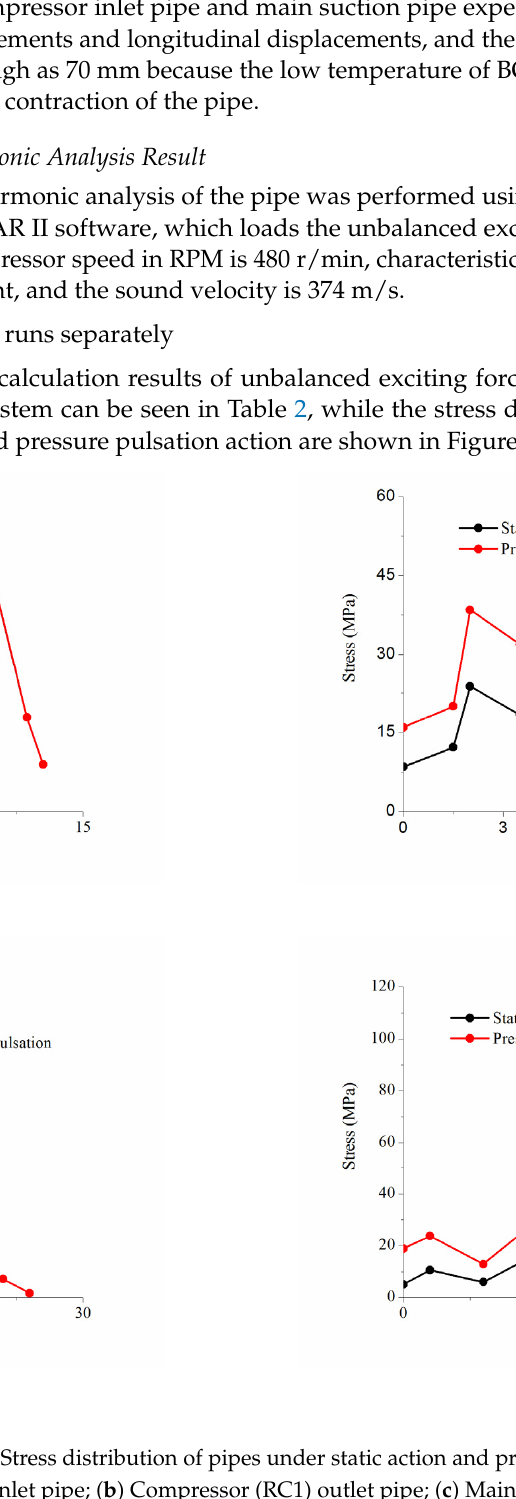
13 of 22 Figure 11. Displacement distribution: ( a ) Compressor (RC1) inlet pipe; ( b ) Compressor (RC1) outlet